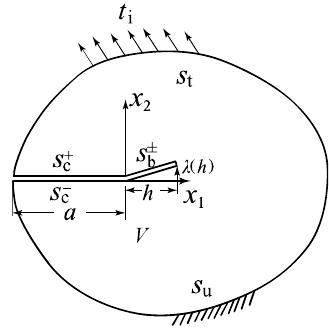
Figure 1: Straight crack with slightly kinked and curved